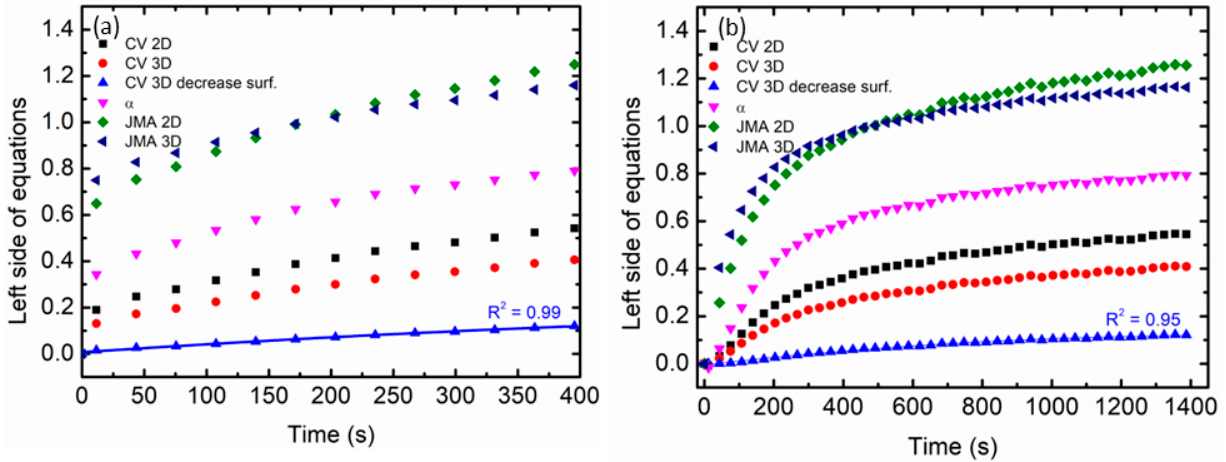
Figure 4. The calculation of the various kinetic equations for MgH 2 –10 wt.% Ni 0.6 Zn 0.4 O samples is shown in Table 4 for ( a ) absorption kinetics at 250 °C and ( b ) desorption kinetics at 300 °C. The DSC curves for milled MgH 2 and MgH 2 –10 wt.% Ni 0.6 Zn 0.4 O samples were